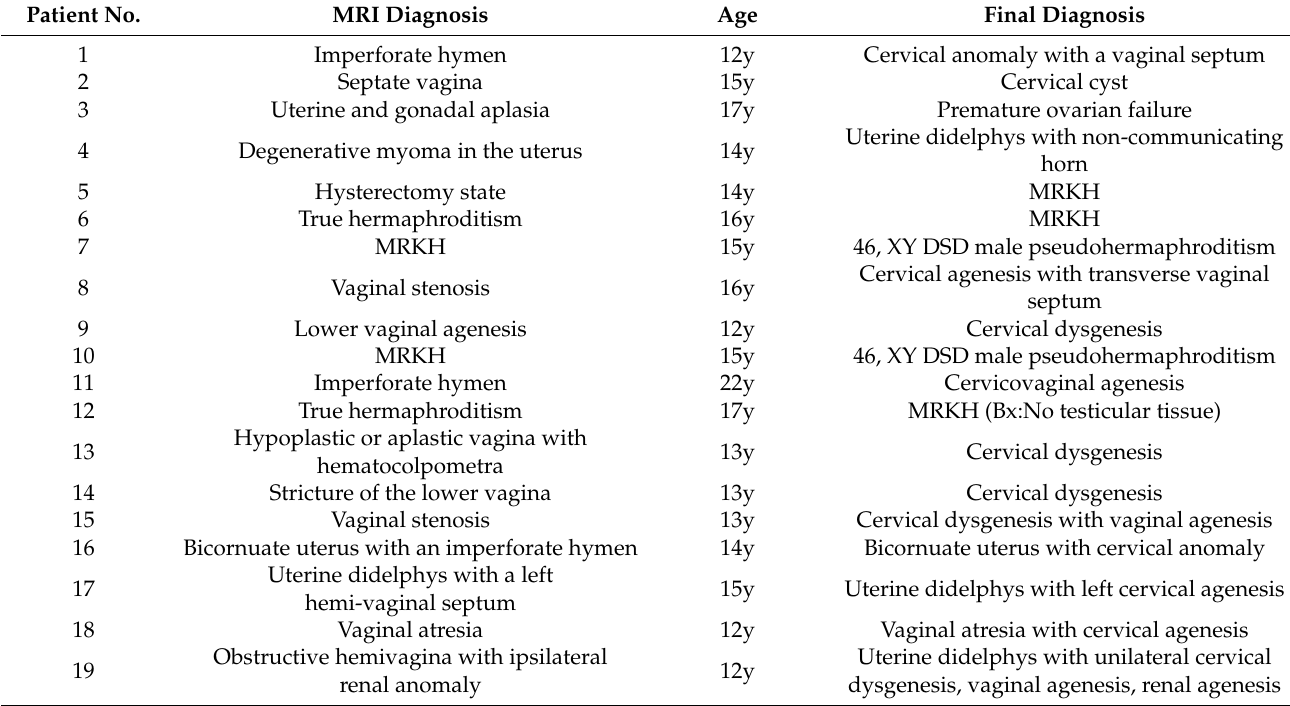
Table 2. Comparisons between the MRI and final diagnoses in 19 patients with discrepancy results. Patient No.